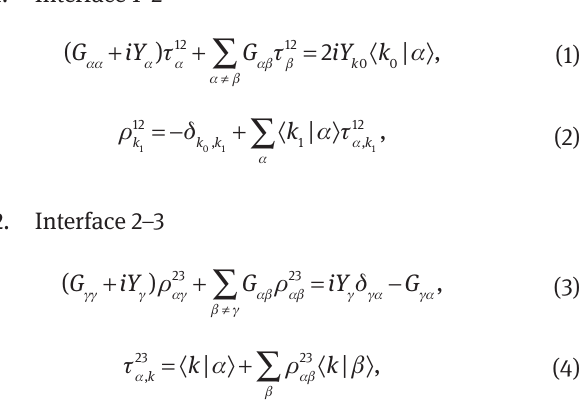
plane waves k = k